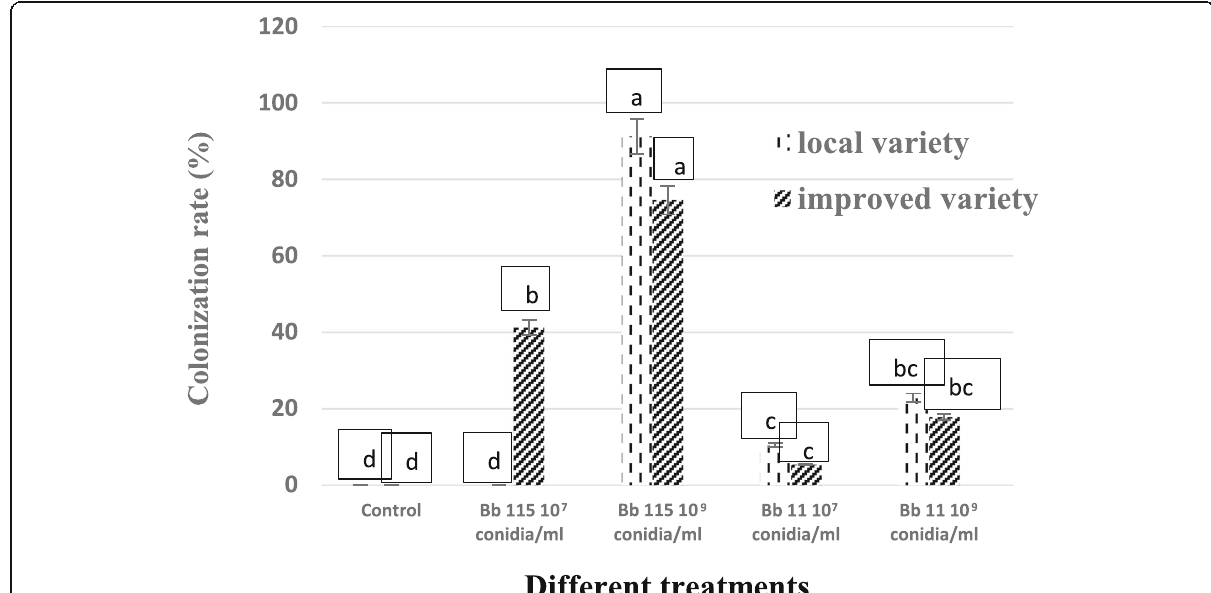
Fig. 2 Leaf colonization rate (%) by Beauveria bassiana in two tomato varieties with seed coating inoculation. Histograms with the same letters are not significantly different at the 5% level (SNK). With Bb115 10 Λ 7 conidia/ml = Beauveria bassiana Bb115 at 10 7 conidia/ml; Bb115 10 Λ 9 conidia/ml = Beauveria bassiana Bb115 at 10 9 conidia/ml; Bb11 10 7 conidia/ml = Beauveria bassiana Bb11 at 10 7 conidia/ml; Bb11 10 9 conidia/ml